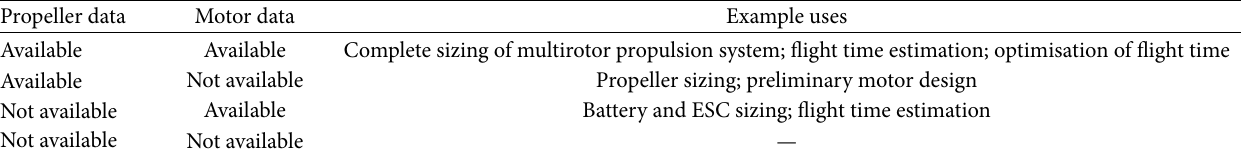
Table 7: Uses of sizing methodology based on data